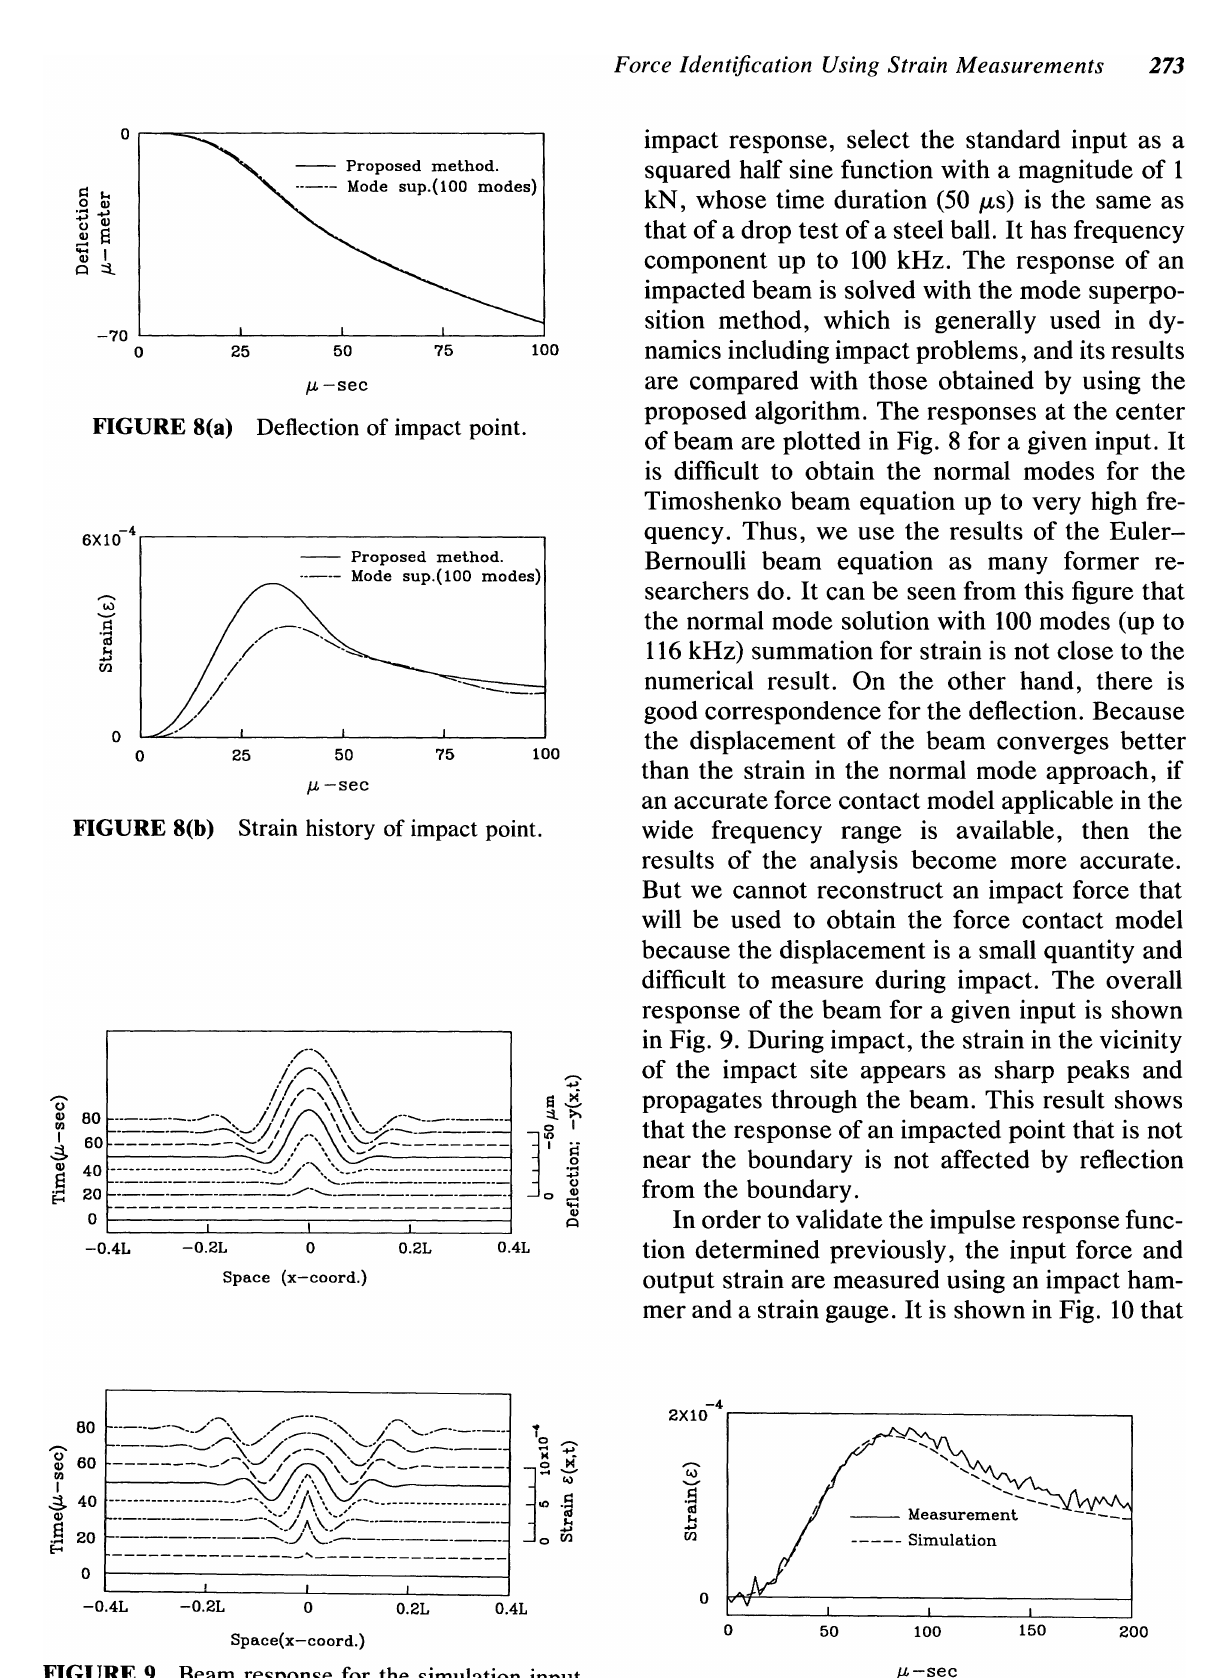
FIGURE 10 Measured and simulated strain history at impact